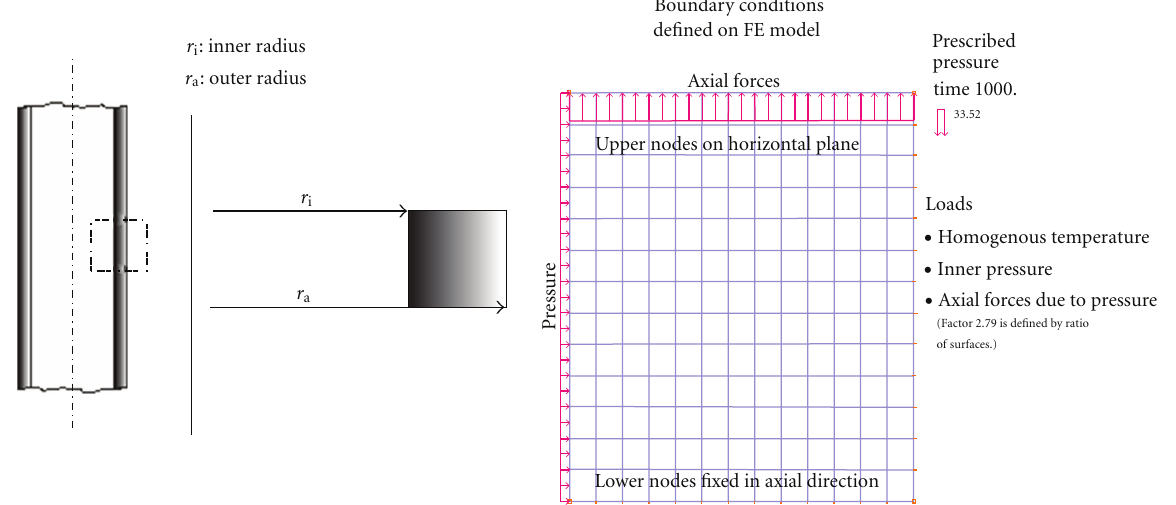
Figure 6: 2D representation of pipe structure, dimensions, loads, and boundary conditions.